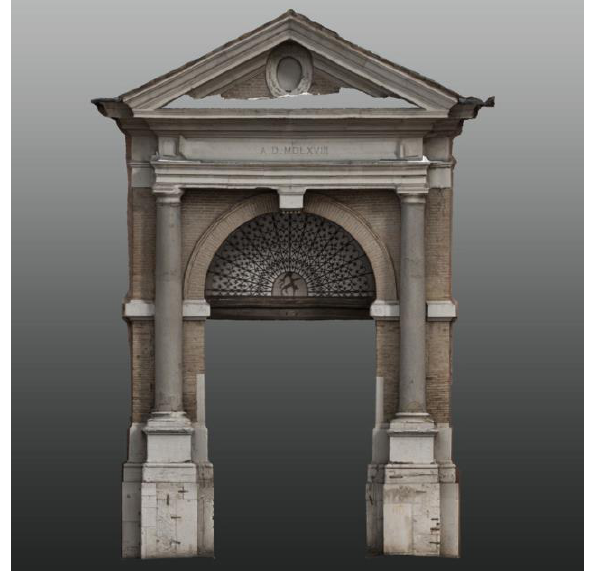
Figure 7. Ortho-graphic view of Porta Sisi with double shadows (apparent colour, global illumination and ray-tracing).